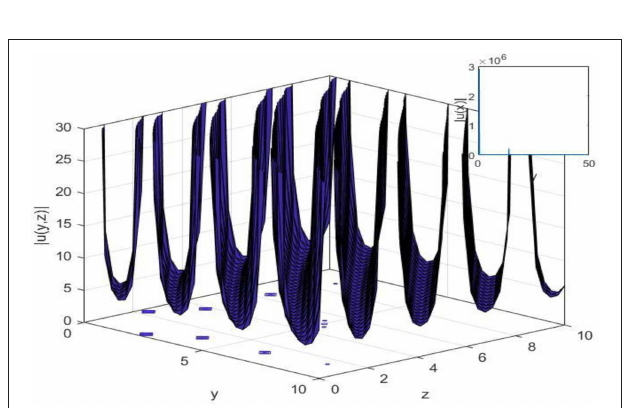
FIGURE 6 | 2-D, 3-D, and contour plot of periodic singular soliton solution Equation (25) when λ γ 3 a 0 0.5, b 0 = =